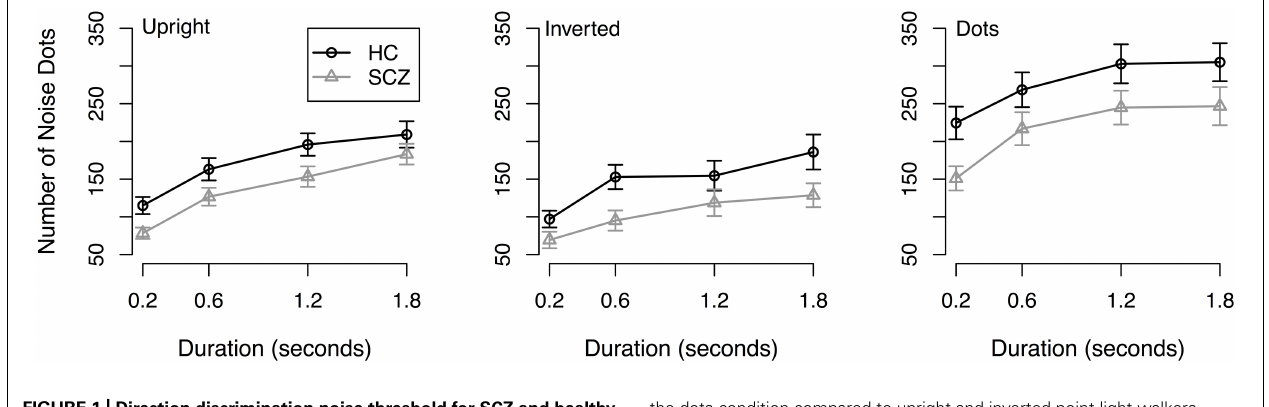
FIGURE 1 | Direction discrimination noise threshold for SCZ and healthy controls in the three conditions and across all durations. Threshold is expressed as the number of dots in a dynamic noise mask; the point-light walker consisted of 11 dots. Both groups showed better performance in